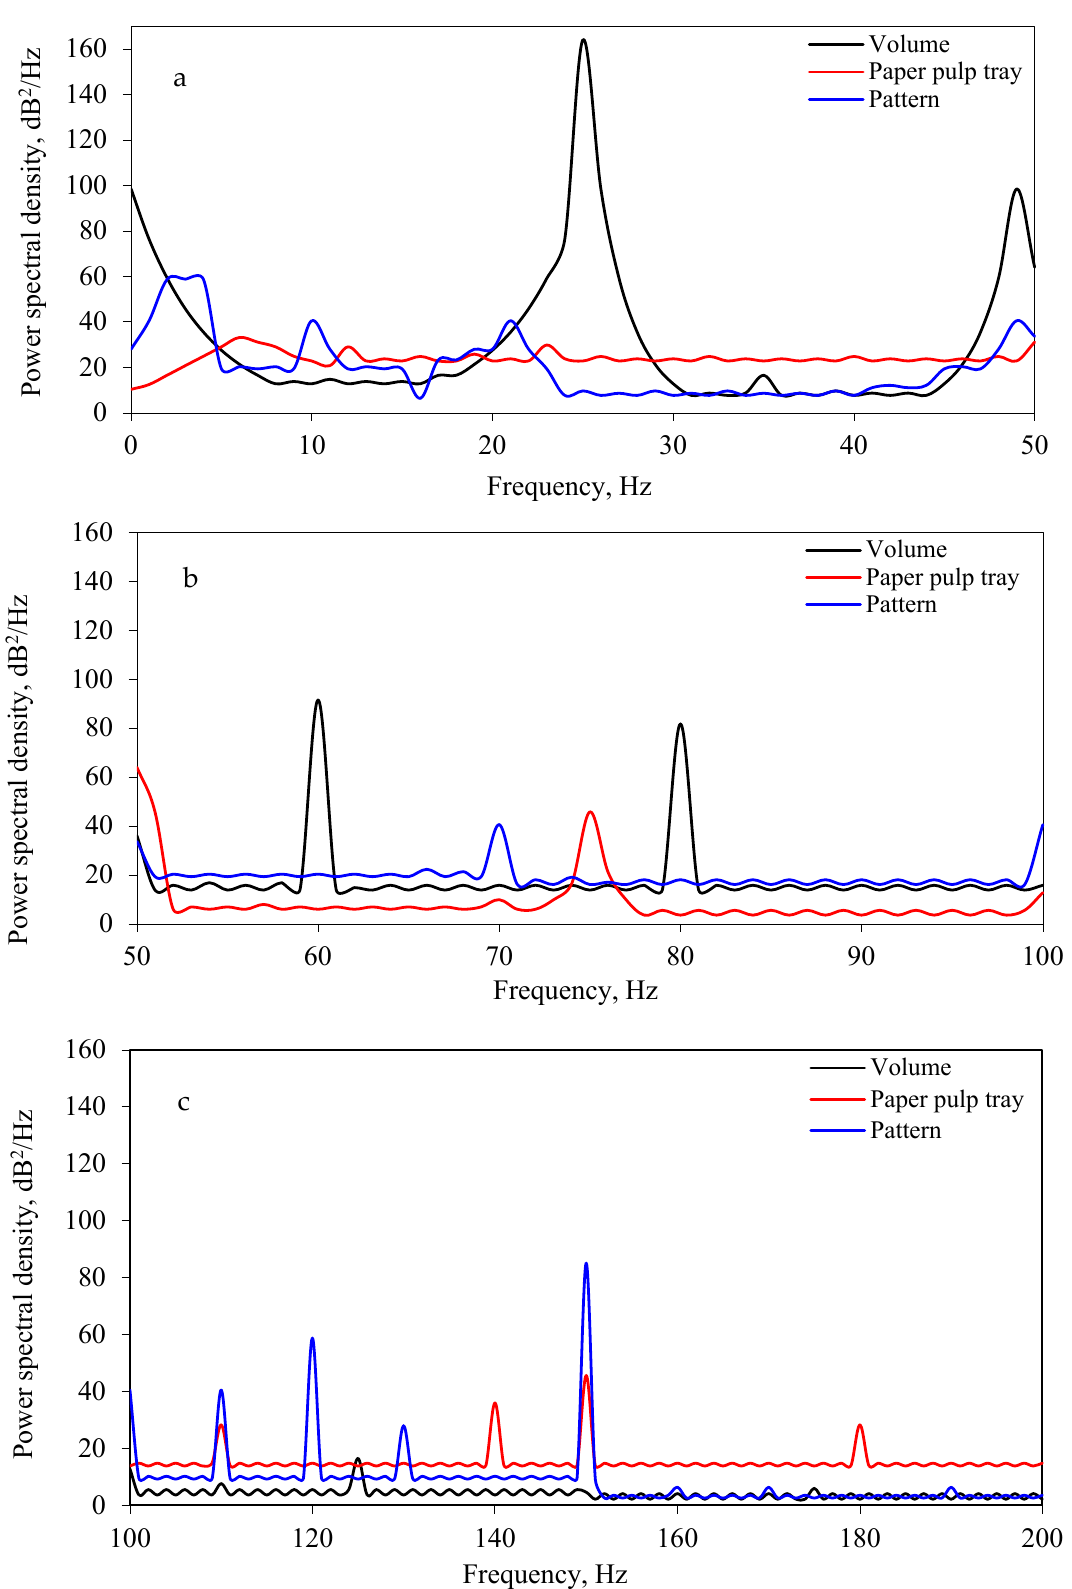
Figure 13. Relationship between the power spectral density, dB 2 /Hz, and frequency (Hz) of canta- loupe with different packing methods and a duration of 5 min: ( a ) 0–50 Hz, ( b ) 50–100 Hz, ( c ) 100– 200 Hz.